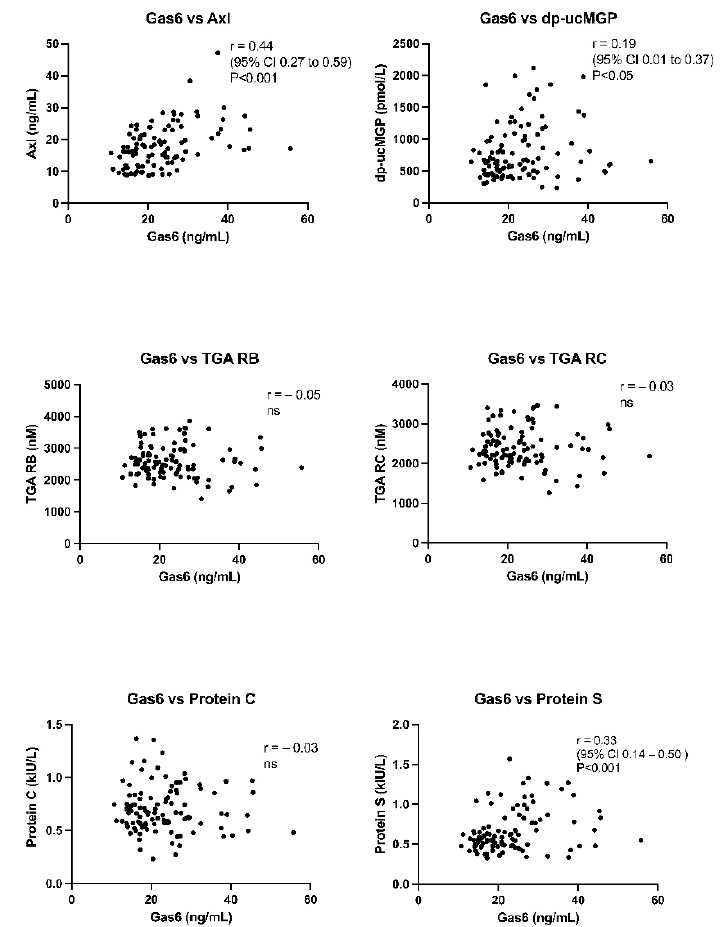
Figure 3. Correlations between growth arrest-specific gene 6 protein (Gas6) and soluble-Axl receptor (Axl), dephospho-uncarboxylated MGP (dp-ucMGP), thrombin generation assay (TGA), protein C and S. TGA was performed with two different reagents: TGA reagent B (RB), which has a low concentration of phospholipids and tissue factor (TF), and TGA reagent C (RC) high, which has a high concentration of TF. Ns (no significant change).